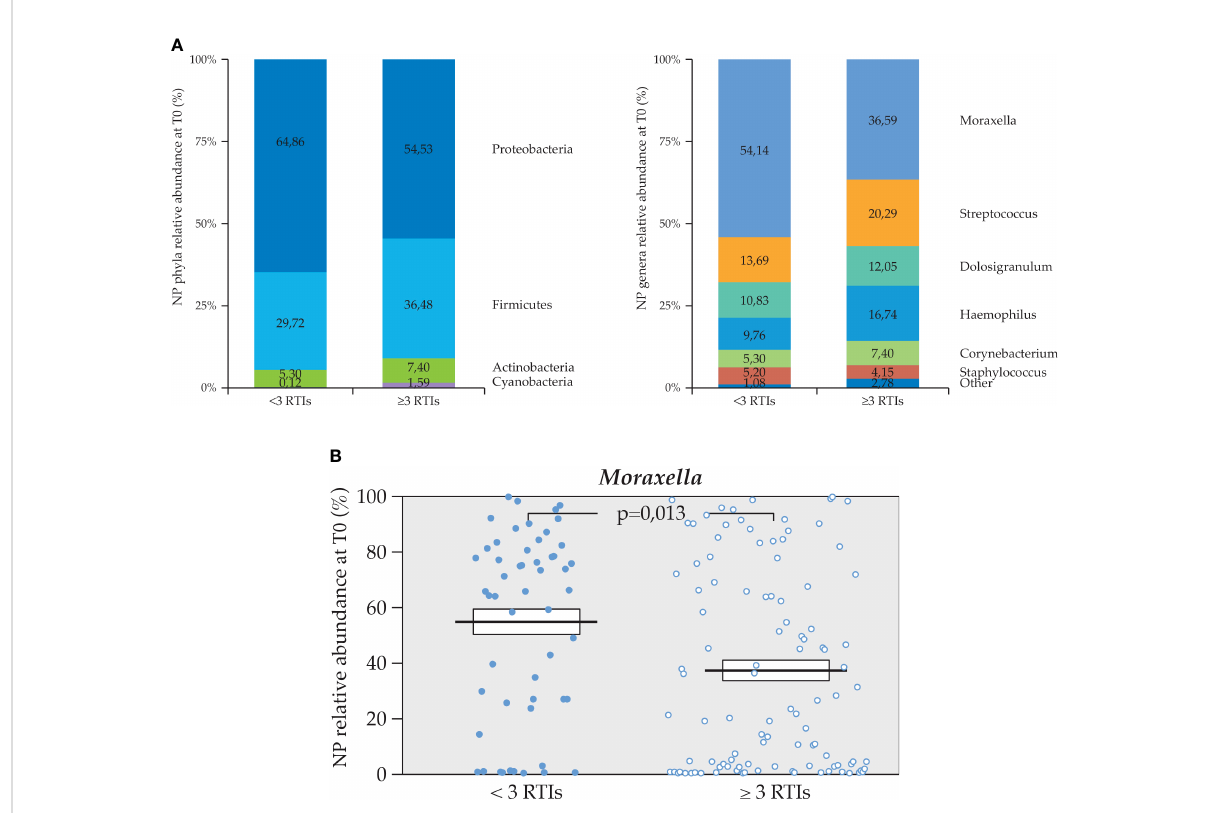
FIGURE 5 Relative percentage abundance of phyla and genera in the NP microbiota at T0. (A) Differences of NP microbiota pro fi les per number of RTIs in the 6 months prior to the study (n=53 <3 and n=104 ≥ 3 RTIs), (B) Statistically signi fi cant difference in relative abundance of Moraxella spp. between the two subgroups (Mann U Whitney